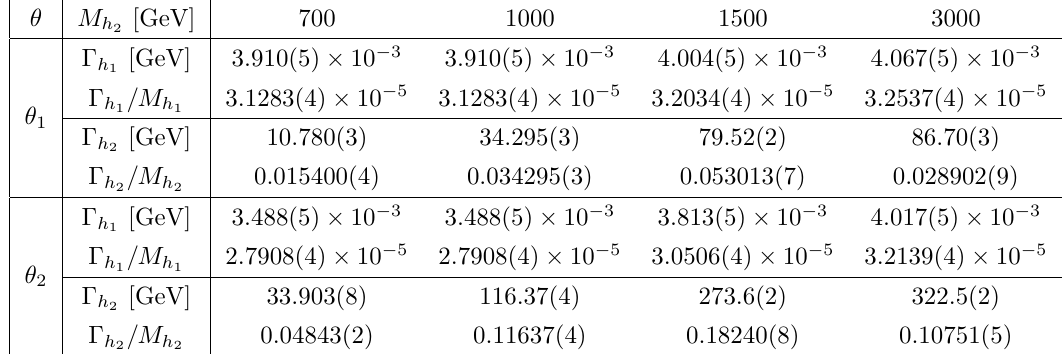
Table 2 . Decay widths and (cid:0) =M ratios of the two physical Higgs bosons h Singlet extension of the SM for the considered benchmark points. Details as in table 1. The error due to rounding and numerical integration is given in brackets.